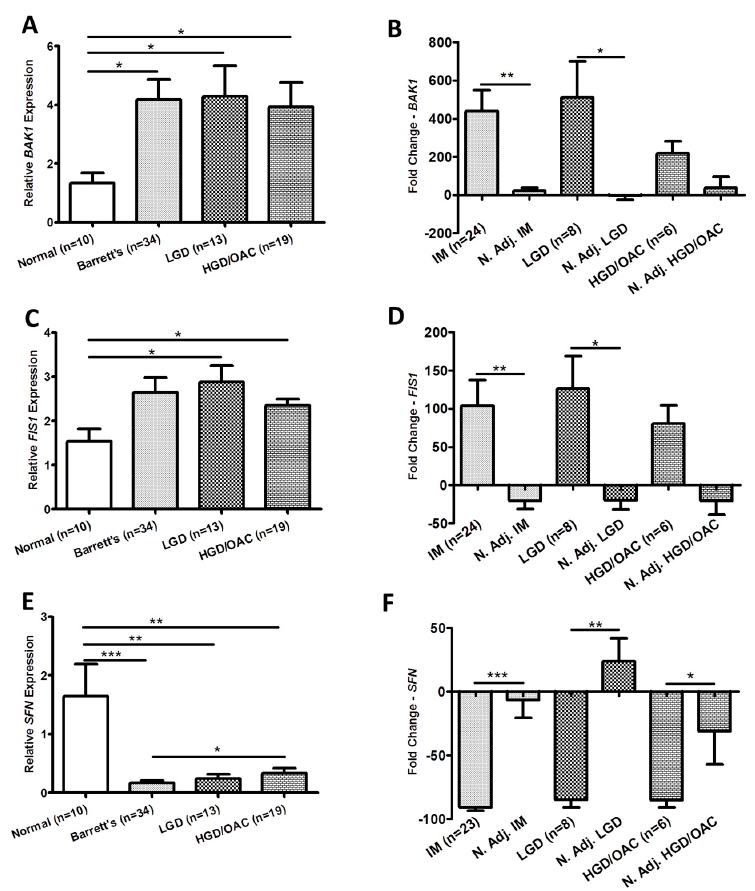
Figure 2. Global mitochondrial function gene expression across the disease sequence in diseased ( A , C , E ) versus matched normal adjacent ( B , D , F ) in vivo samples. ( A ) BAK1 ( p < 0.05), ( C ) FIS1 ( p < 0.05) and ( E ) SFN ( p < 0.0001) were found to be differentially expressed between independent groups in the Barrett’s disease sequence (Mann Whitney U) (Dunns post-hoc test). Kruskal-Wallis tests were used to investigate differences across the in vitro Barrett’s sequence for BAK1 ( p = 0.037), FIS1 ( p = 0.108) and SFN ( p < 0.0001). ( B ) BAK1 ( p < 0.01), ( D ) FIS1 ( p < 0.01) and ( F ) SFN ( p < 0.001) were found to be differentially expressed across the Barrett’s disease sequence compared to matched normal adjacent samples (Wilcoxon Sign Rank). Bars denote mean ± SEM. * p < 0.05, ** p < 0.01 and *** p < 0.001.